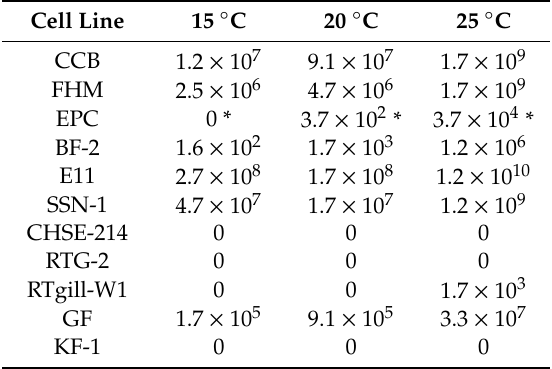
Table 3. Chinook salmon bafinivirus Cefas-W054 titer in fish cell lines incubated at three di ff erent temperatures: 15, 20 and 25 ◦ C. The viral titer is expressed as TCID 50 mL − 1 . An asterisk (*) denotes a strong change of colour of the media (acidic pH) in inoculated